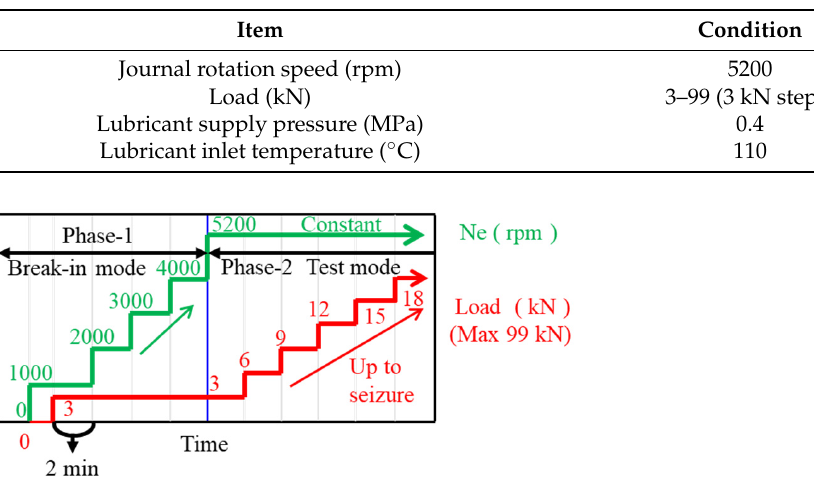
Figure 9. Method of calculating bearing specific load. 2.7. AE Measurement Acoustic emission (AE) measurements were made during the seizure test to investigate the change in wear up to the occurrence of seizure and the effect of the wear state on reducing friction. The AE measurement conditions are given in Table 7. As shown in Figure 2, an AE sensor was installed on top of a connecting rod. The measured AE waves were recorded in a dedicated high-resolution data logger. The measured signals were filtered using a high-pass filter at 100 kHz to remove the influence of journal rotation. Table 7. AE measurement conditions. Item